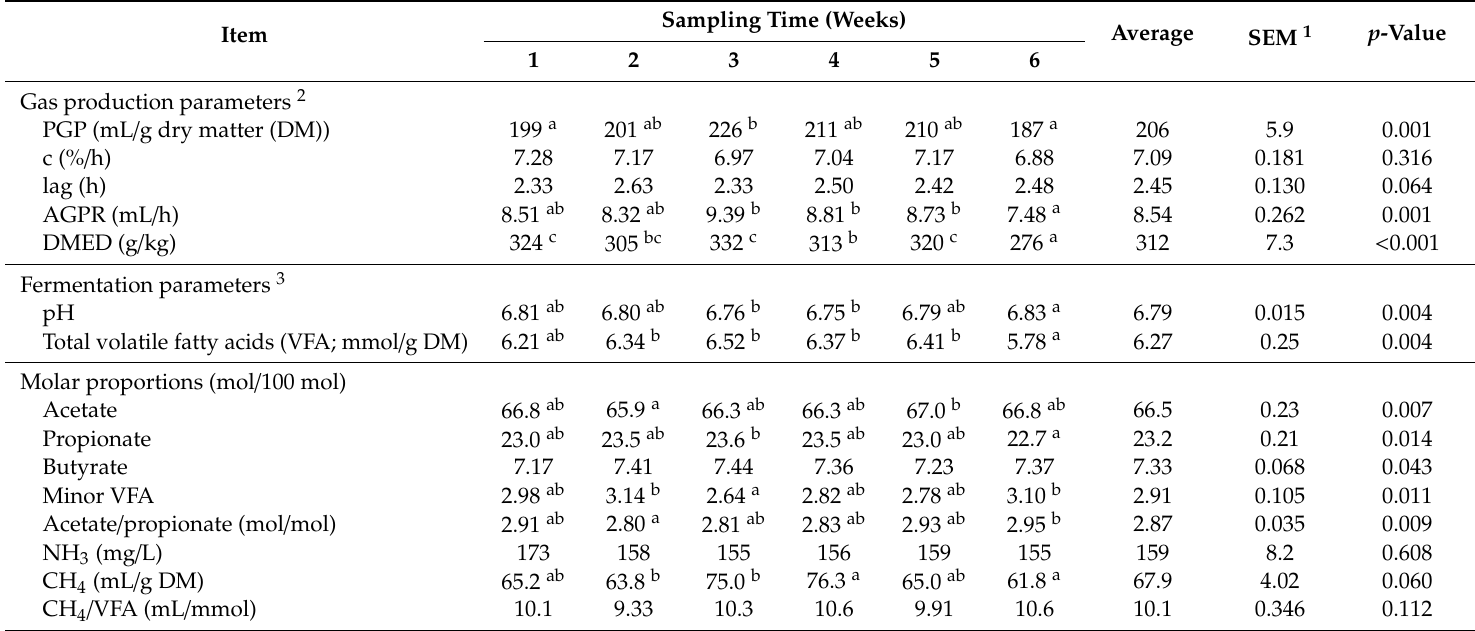
Table 3. Gas production kinetics and fermentation parameters of tomato pomace samples taken from two processing plants at weekly intervals during the tomato harvesting campaign and